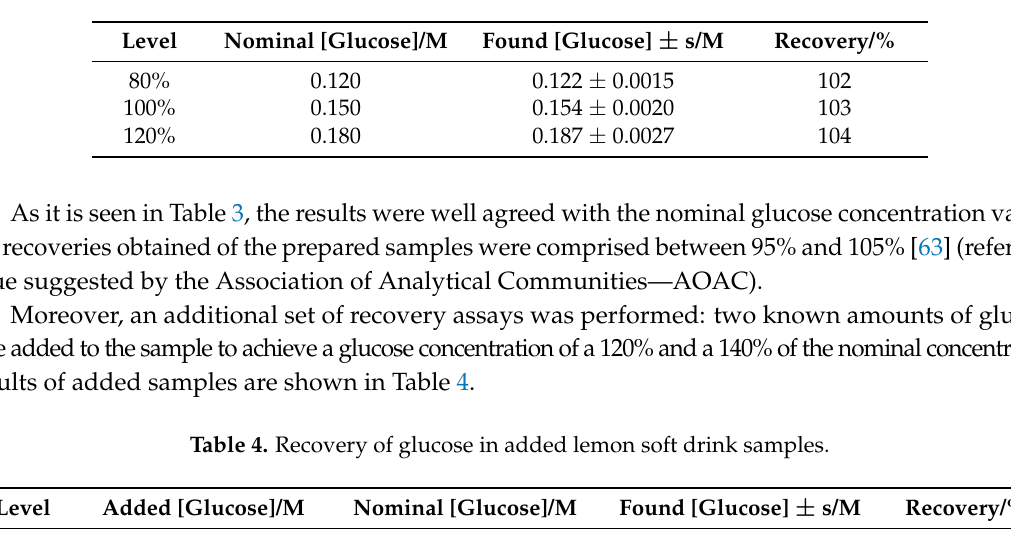
Table 3. Recovery of glucose in prepared lemon soft drink samples.